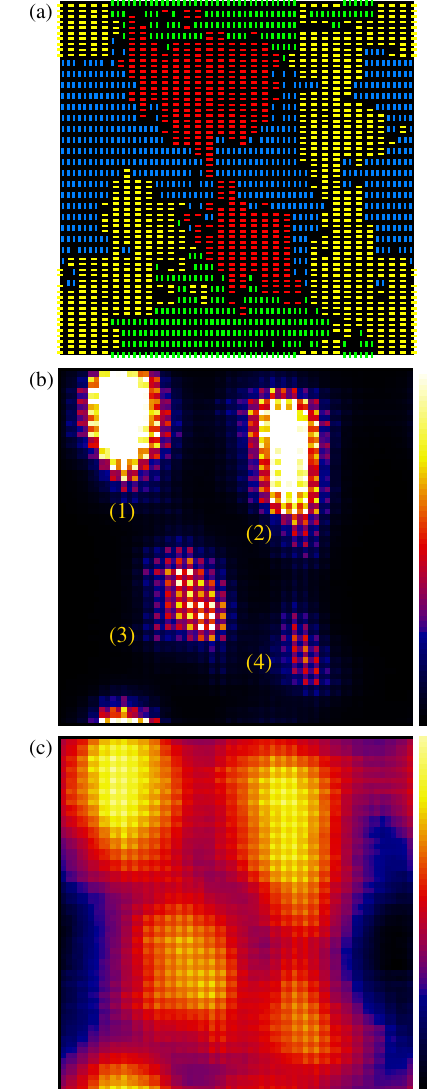
FIG. 26. Example of domain structure and spinon string density for an instance of the bimodal random- J model. In (a), the bonds are color coded as in Fig. 8. The mean spinon string density ρ ð x; y Þ is graphed on a linear scale in (b), with the color bar corresponding to ρ ∈ ½ 0 ; 0 . 002 (cid:5) . The actual maximum value is ρ ≈ 0 . 017 , but all ρ > 0 . 002 are shown as white in order to make the weaker features more visible. In (c), the color scale is for ln ð ρ Þ ∈ ½ − 15 ; − 3 (cid:5) (the full range of the computed values). The labels 1 – 4 for the spinon regions in (b) are referenced in Fig.